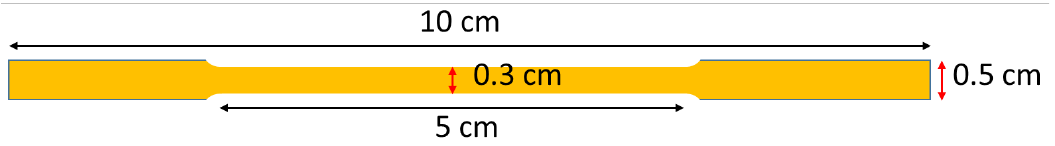
Figure 1. The schematic figure of the tensile specimen.